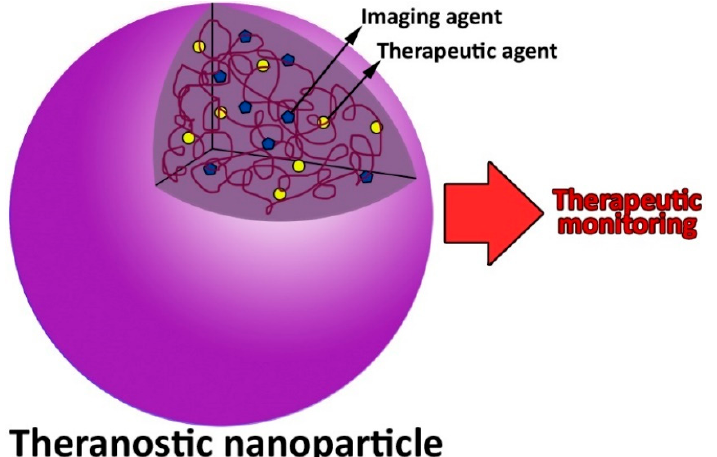
Figure 2. A theranostics nanoparticle used for disease diagnosis, therapy, and monitoring.